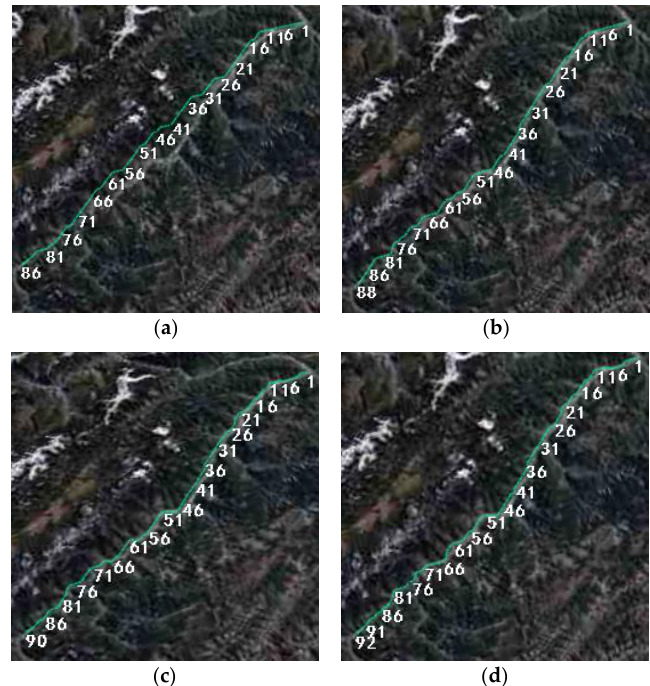
Figure 13. Experiment results with different height cost coefficients 𝜀 . ( a ) 𝜀 = 0; ( b ) 𝜀 = 1; ( c ) 𝜀 = 2; ( d ) 𝜀 = 2.5.